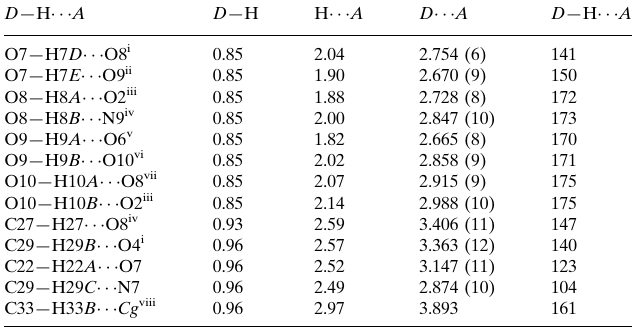
Hydrogen-bond geometry (A˚ , (cid:2)